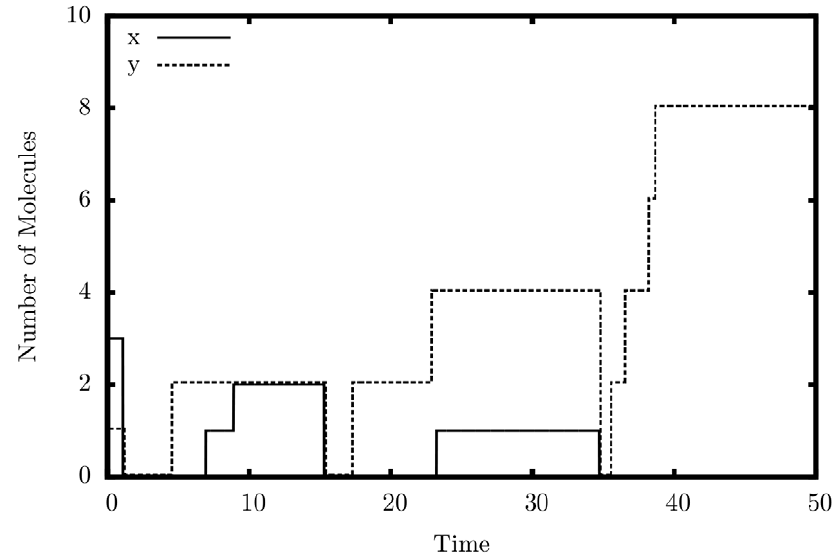
Figure 11. Simulation output of the logarithm construct. x ~ 16 , y ~ 1 .